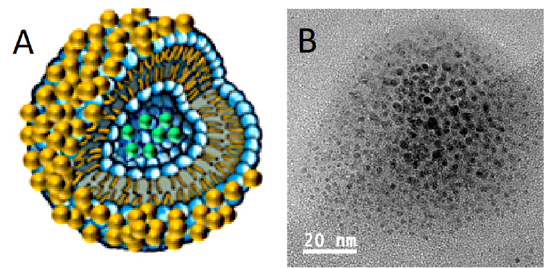
Figure 7. TEM image of nanoshells prepared by seeding gold nanoparticles onto a silica core, fol- lowed by a second reduction of gold chlorate to create a continuous gold film. Adapted from [78], published by ACS, 2005.